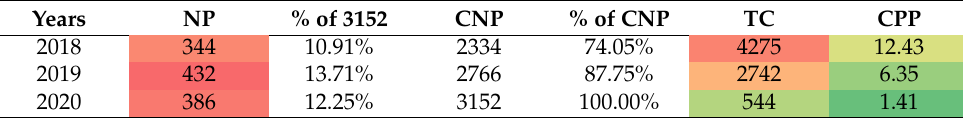
Figure 8. Keyword co-occurrence cluster of PSEP papers.